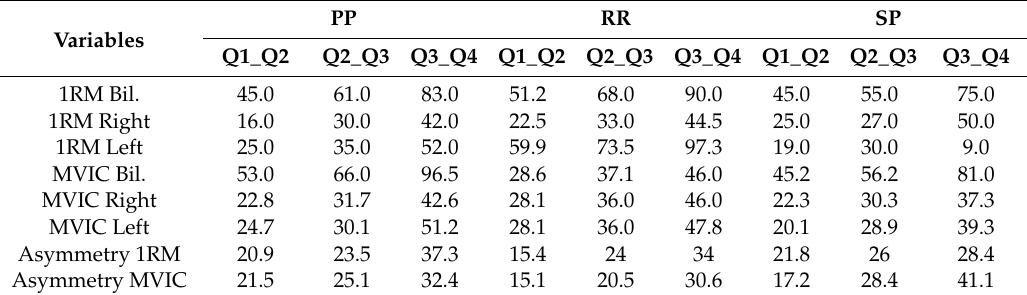
Table 6. Quartiles of force variables of sample by type of Multiple Sclerosis.